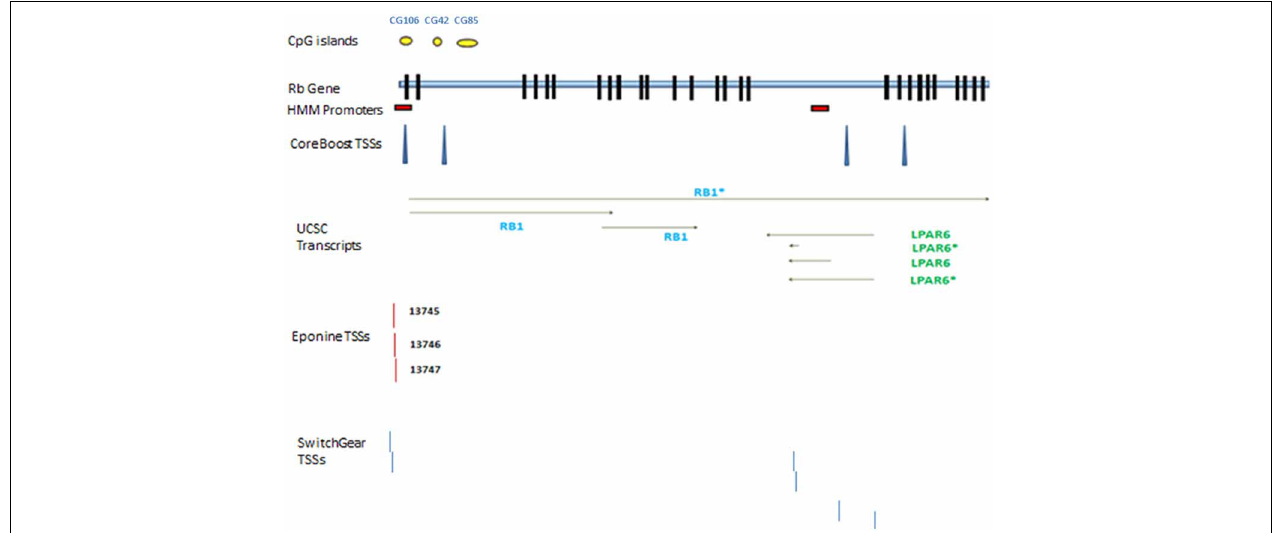
FIGURE 1 | Rb1 gene structure. Transcribed RNAs from this locus identified by UCSC genome browser. The exons are represented by black blocks. Different promoters and transcription start sites of Rb1 locus are shown. The diagram shows a schematic representation of results from different databases and programs which are described in the text. The yellow circles